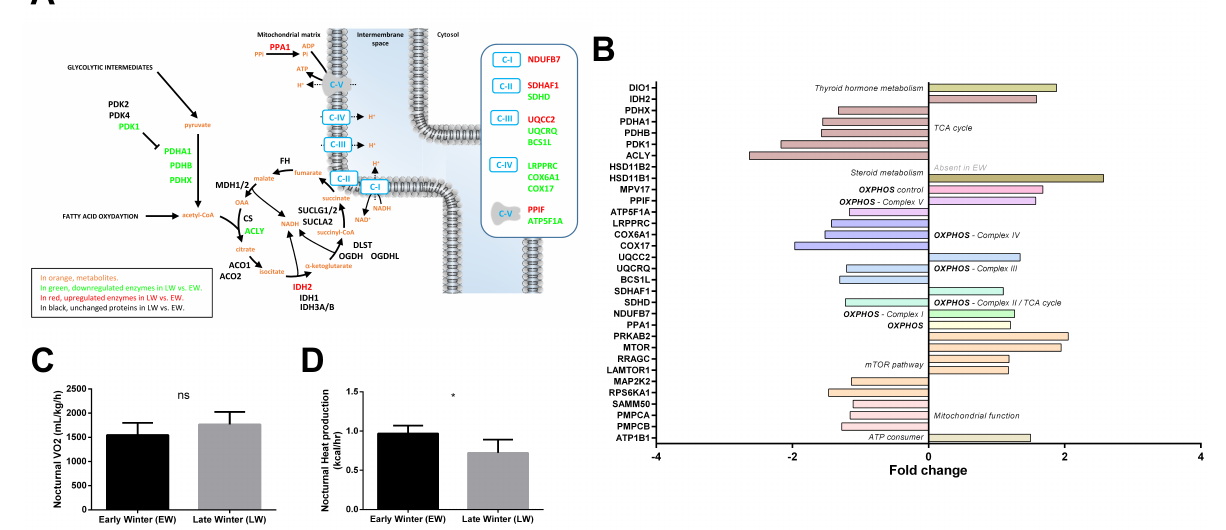
Figure 5. Regulation of liver energy metabolism in grey mouse lemurs during winter. The relative abundance of liver proteins involved in mitochondrial energy metabolism in early (EW) and late (LW) winter mouse lemurs (N = 5/group) is shown using a color code in the corresponding pathways (panel A ), and mean fold changes in LW vs. EW can be visualized in (panel B ) (HSD11B2 was not detected in EW). Although no change could be observed in nocturnal oxygen consumption (VO2) between EW and LW animals (panel C ), nocturnal heat dissipation was significantly lower in LW lemurs (panel D ). * indicates significance at p < 0.05 between EW and LW. ns indicates non